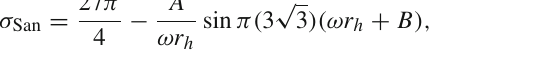
Fig. 8 Effective potential, given by Eq. (14), with l = 1, for non- negative (top panel) and non-positive (bottom panel) values of